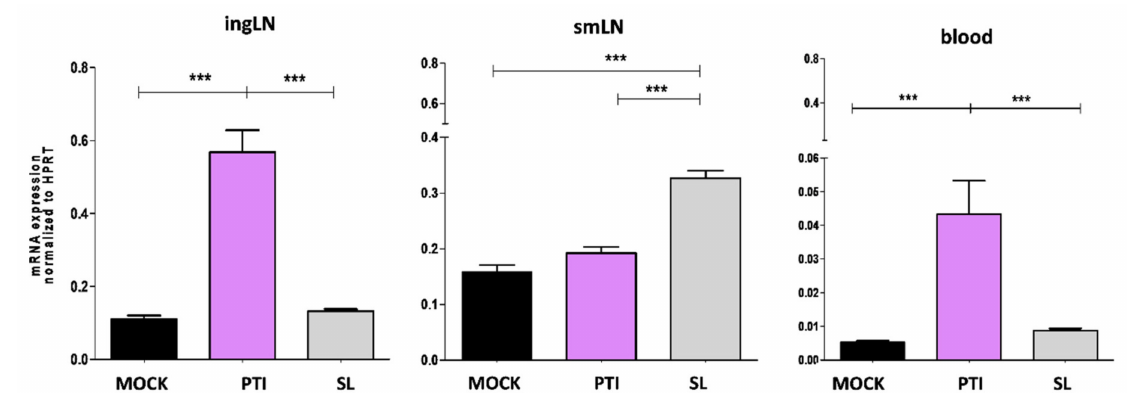
Figure 2. Expression of Mx1 gene by real-time PCR in ingLN, smLN and PBL following sublingual (SL) or peritumoral (PTI) administration of IFN-I or sublingual mock preparation (MOCK) in C57Bl/6 mice implanted with B16-OVA tumor. LNs were explanted 18 h after treatment. Data were normalized to HPRT ( n = 5). *** p <